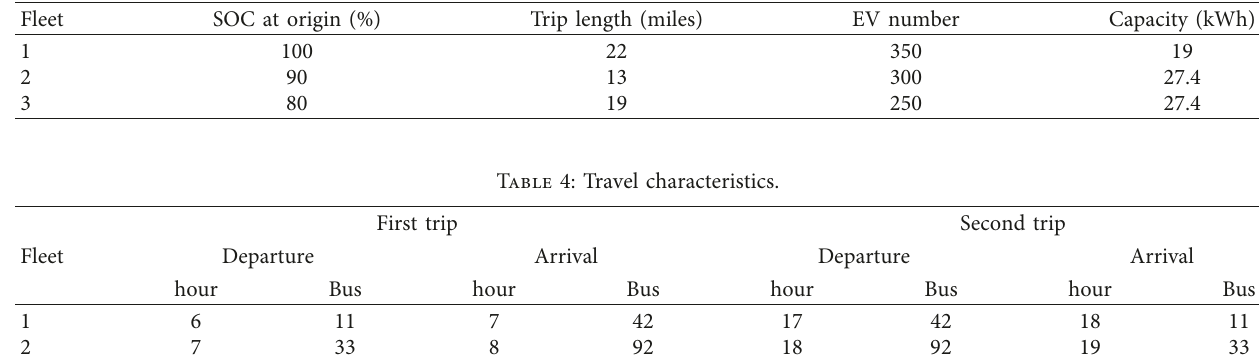
Table 3: PEV fleet features.